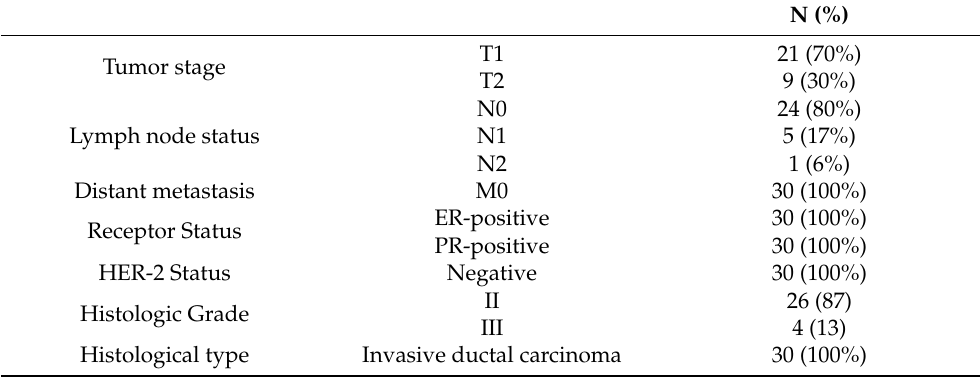
Table 2. Clinical characteristics of untreated